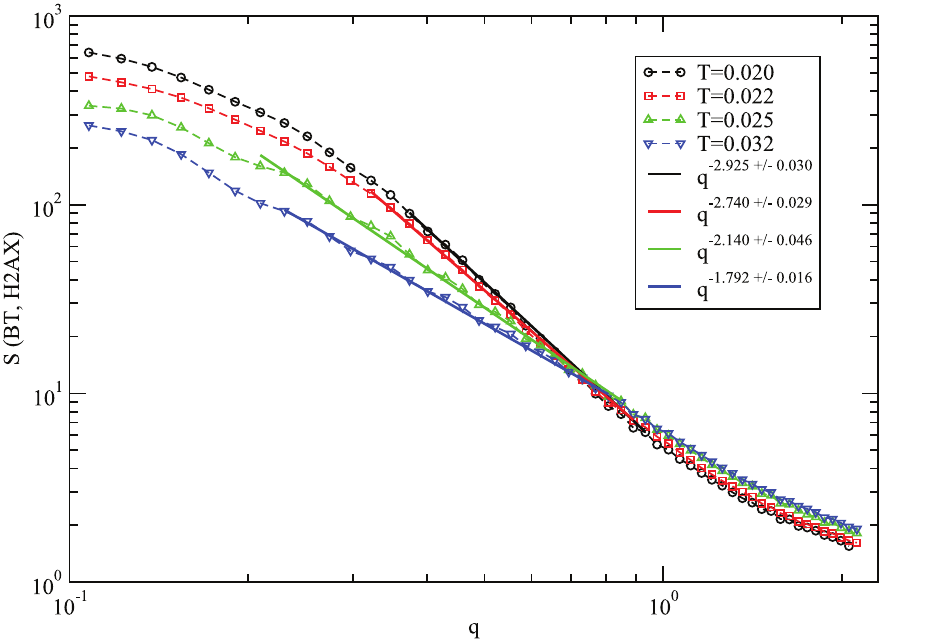
Figure 5. Variation of the structure factor, S(q) , of histone H2AX with the wave vector, q, with BT potentials from simulations (with t=10 7 MCS time) on a 64 3 cubic lattice with 150 independent